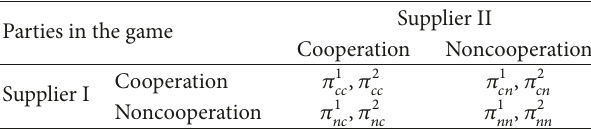
Table 1: Payoff matrix between suppliers. Parties in the game